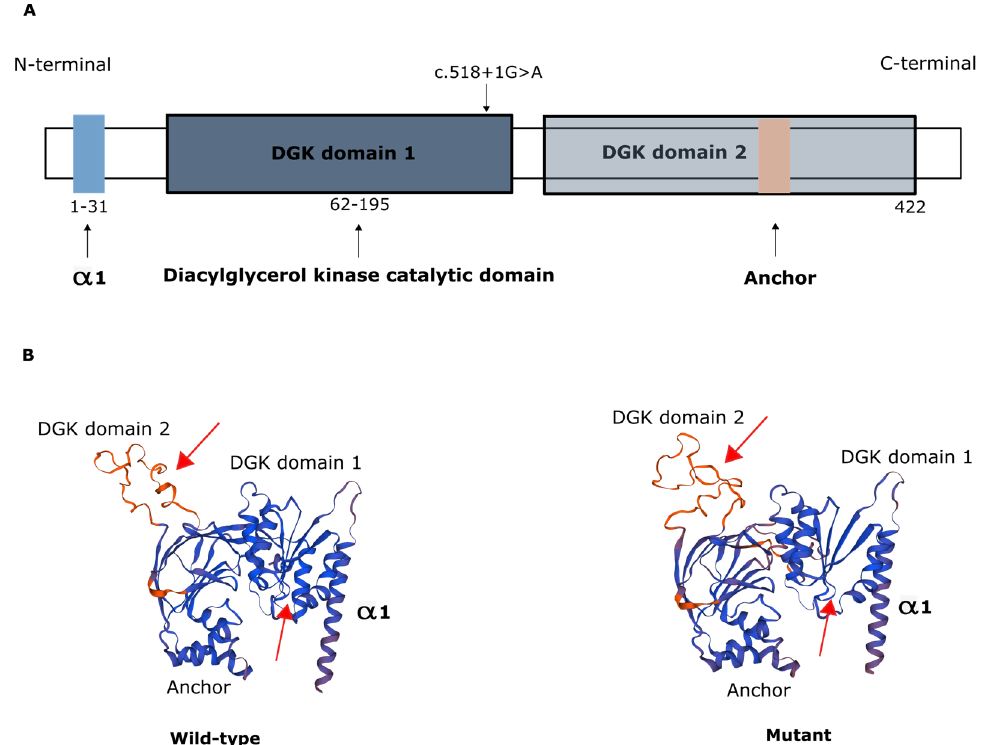
Figure 2. Representation of AGK protein domains. ( A ) Domain structure of AGK, which contains a two-domain fold (DGK domains 1 and 2) that mediates phosphorylation of monoacylglycerols or diacylglycerols, an N-terminal α 1 helix (light blue) that anchors to the membrane, and a C-terminal region with an additional membrane anchor (light brown) helix loop. Schematic depicts the c.518+1G>A variant in the catalytic domain. ( B ) Protein modeling of wild-type AGK and of the AGK variant c.518+1G>A, showing predicted changes in spatial protein structure (red arrows).